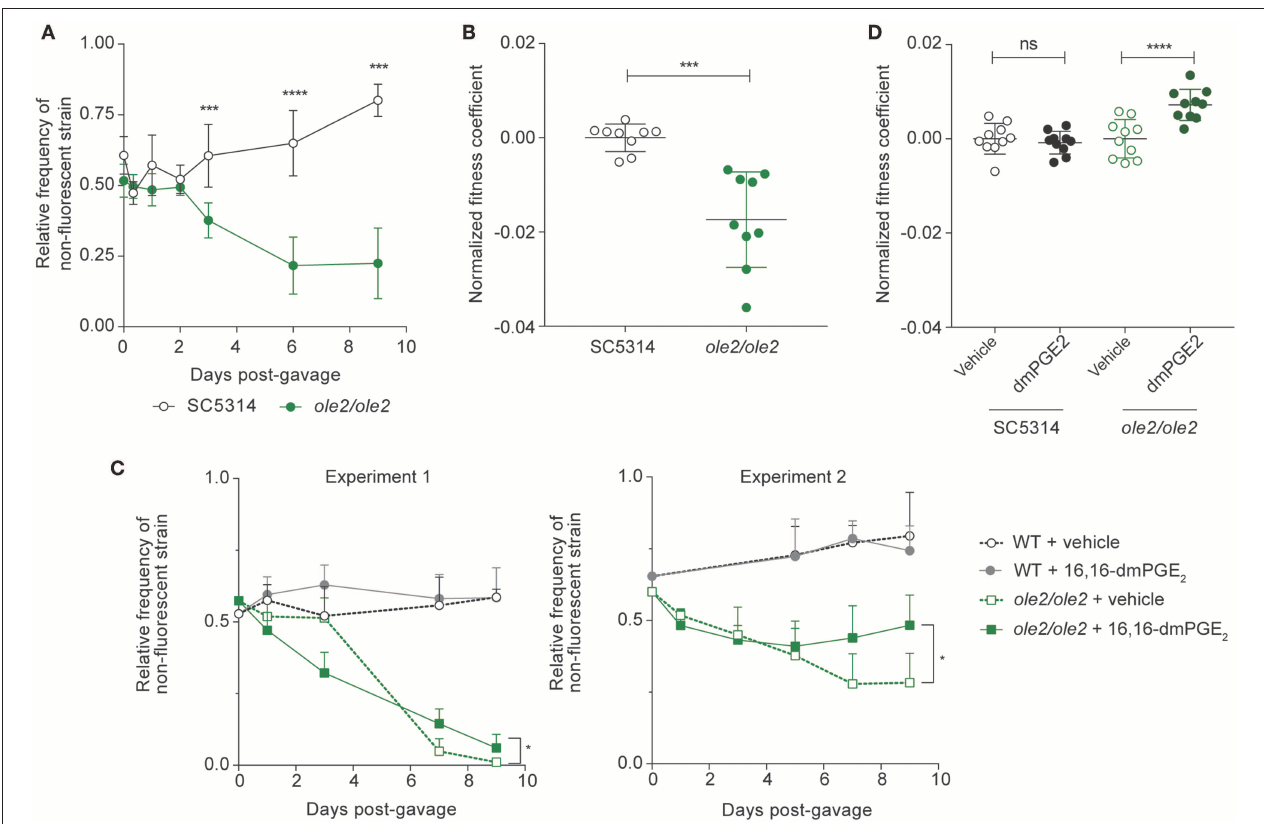
FIGURE 4 | Fungal PGE 2 promotes intestinal colonization by C. albicans . Antibiotics-treated mice were gavaged with the indicated C. albicans strains and stools were plated on YPD agar at regular intervals over 9 days. (A,B) Relative frequencies (A) and fitness coefficients, normalized to the mean of the WT coefficients (B) , of the indicated fungal strains in the intestines of gavaged mice. (C,D) Relative frequencies (C) and fitness coefficients (D) of the indicated fungal strains in mice supplemented with vehicle or 16,16-dimethyl-PGE 2 (dmPGE 2 ). Coefficients for each fungal strain were normalized to the mean of the respective vehicle coefficients. Fitness coefficients were determined as described in Materials and Methods. Data pooled from 2 independent experiments. Mean ± s.d. n = 9 − 10 mice/group. **** p < 0.0001; *** p < 0.001. Student’s t -test (A,B) ; Two-way ANOVA with Sidak’s multiple comparisons test (C,D)